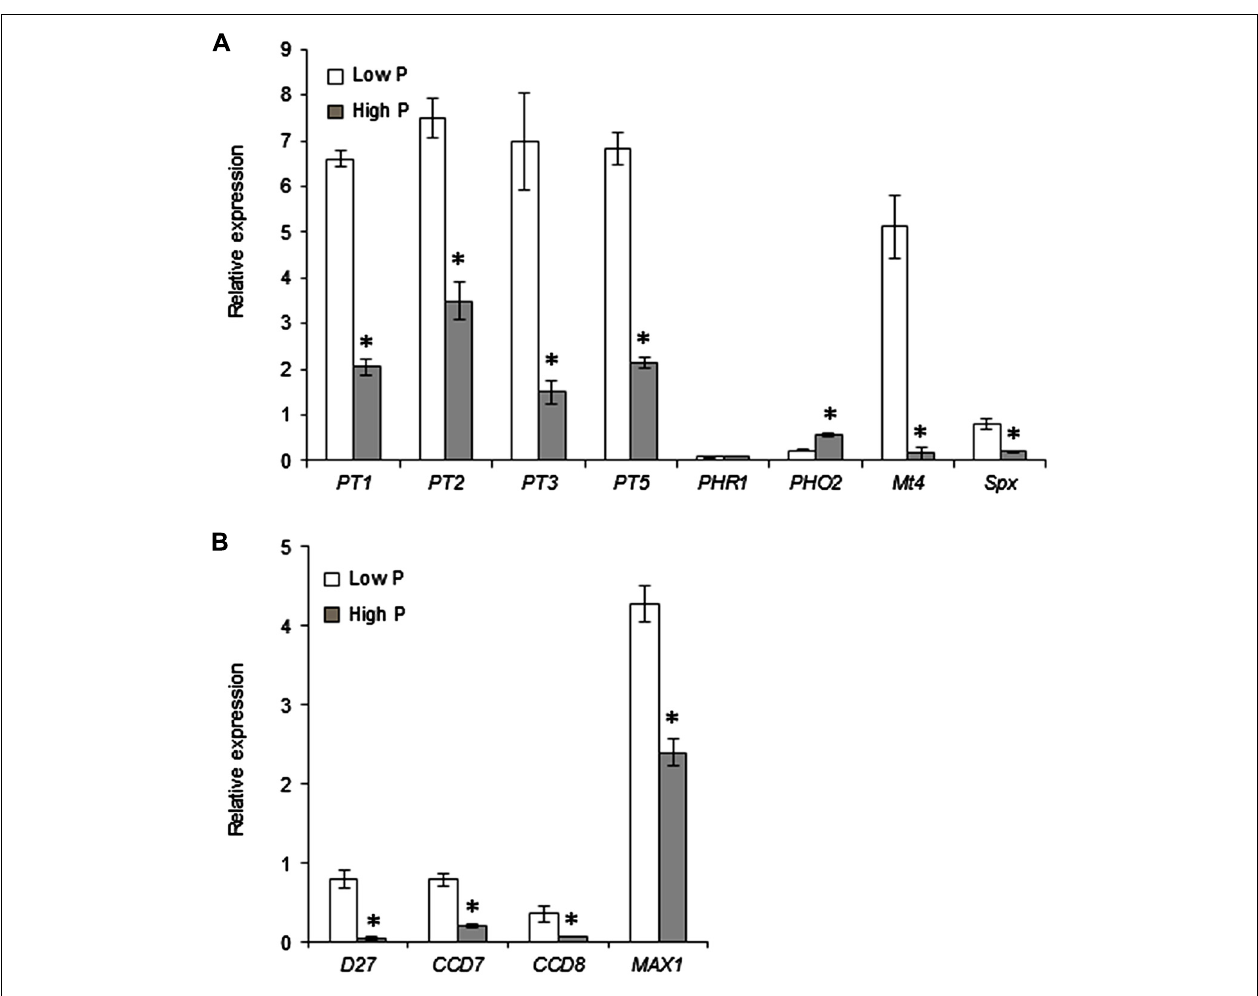
FIGURE 3 | Effect of Pi supply on the expression of selected genes . Expression levels were determined relative to constitutive reference genes. Error bars represent the SEM; n = 3 biological replicates per condition. Asterisks indicate a statistically significant difference between low P and high